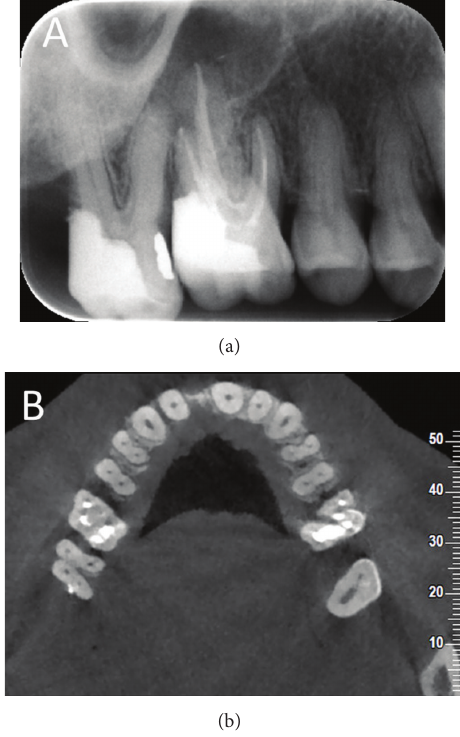
Figure 1: (a) Preoperative radiography showed that the tooth had two roots and no periapical radiolucency. (b) CBCT image revealed the absence of palatal root and two roots with two canals